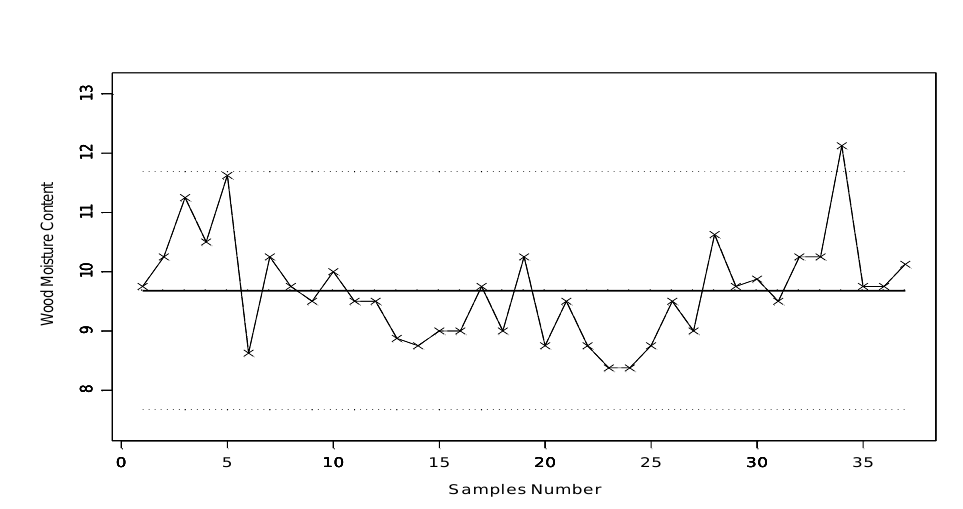
Fig. 5. AMR control chart for wood moisture